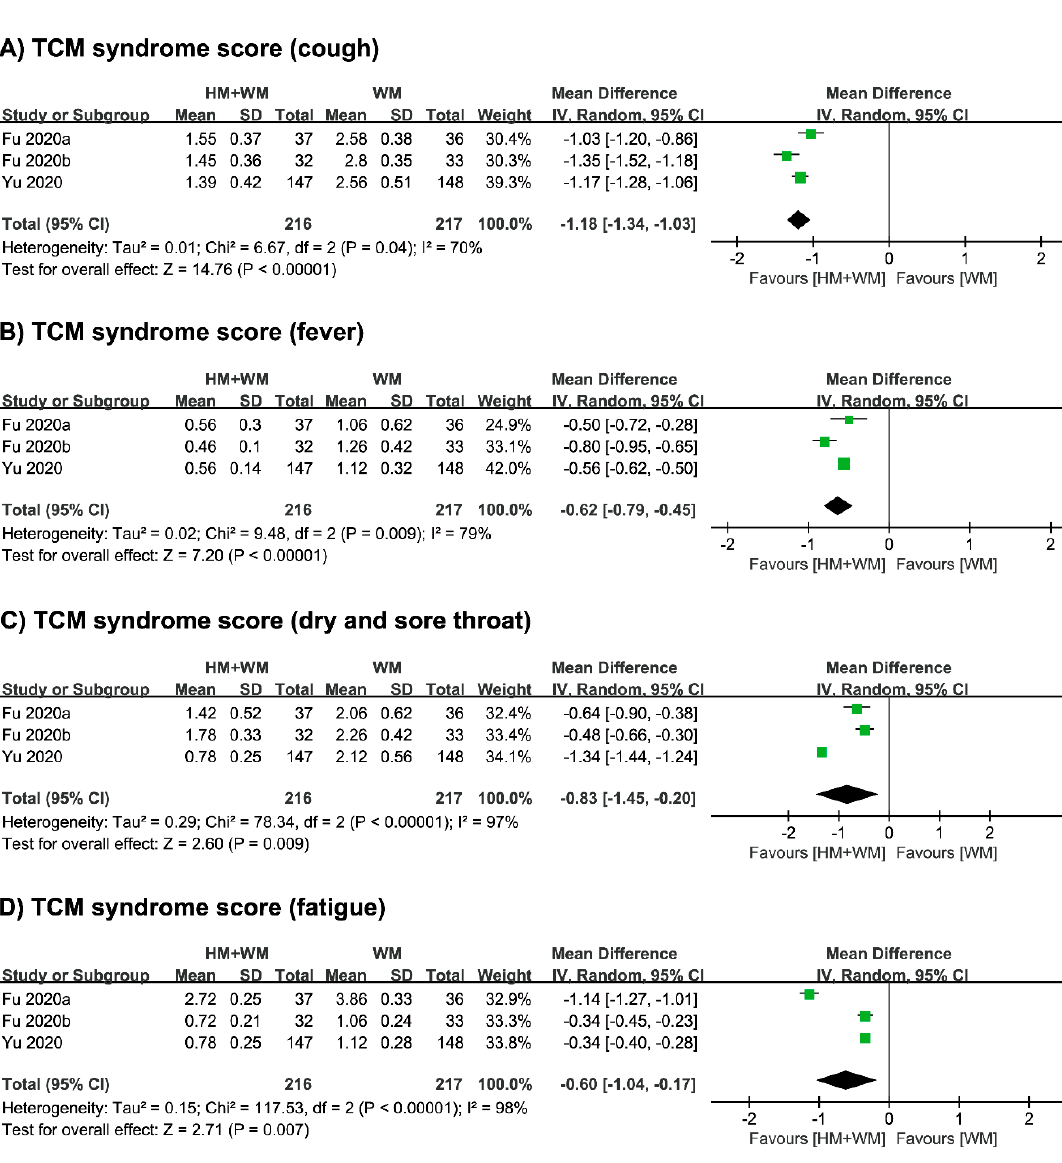
Figure 4. Comparison of herbal medicine and Western medicine (HM + WM) vs. Western medicine (WM) on TCM syndrome score of ( A ) cough; ( B ) fever; ( C ) dry and sore throat; ( D ) fatigue.